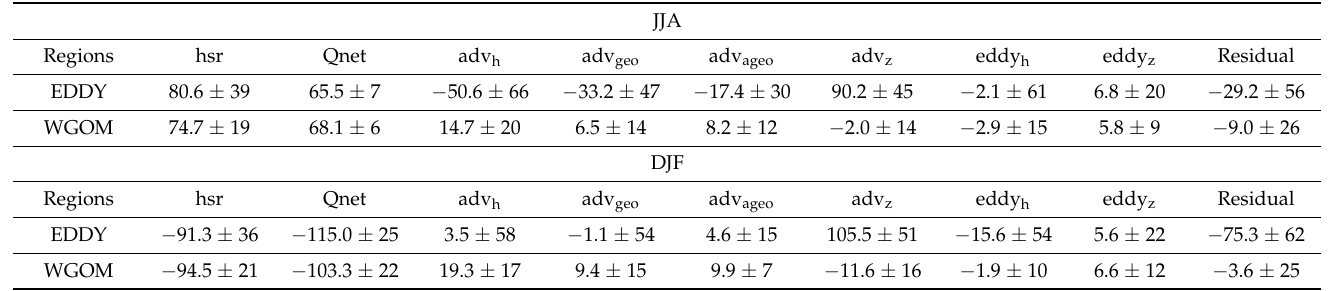
Table 3. Same as Table 2 except averaged over summer (JJA) and winter (DJF) seasons.